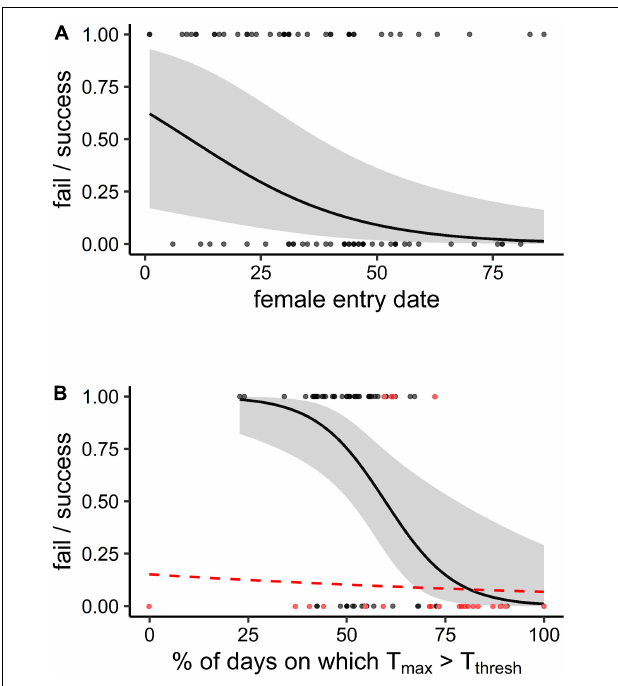
FIGURE 4 | The binomial probability of breeding attempt success [0 = fail, 1 = successfully fledging at least one chick)] by the southern yellow-billed hornbills ( Tockus leucomelas ) as a function of (A) the female entry date (days since the start of the season, i.e., 19 October), and (B) the percentage DaysT thresh {days during the attempt on which T max [mean maximum daily air temperature (T air )] > T thresh (T air = 34.5 ◦ C)} for drought seasons (red dashed line; not significant) and non-drought seasons (solid black line; significant). The 95% confidence intervals are shown for significant